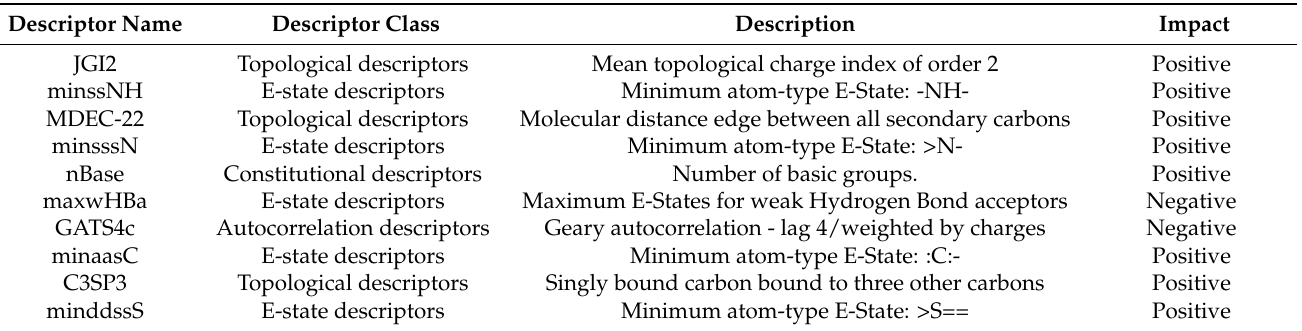
Table 5. Details of the top ten important descriptors that contribute to the prediction of respiratory